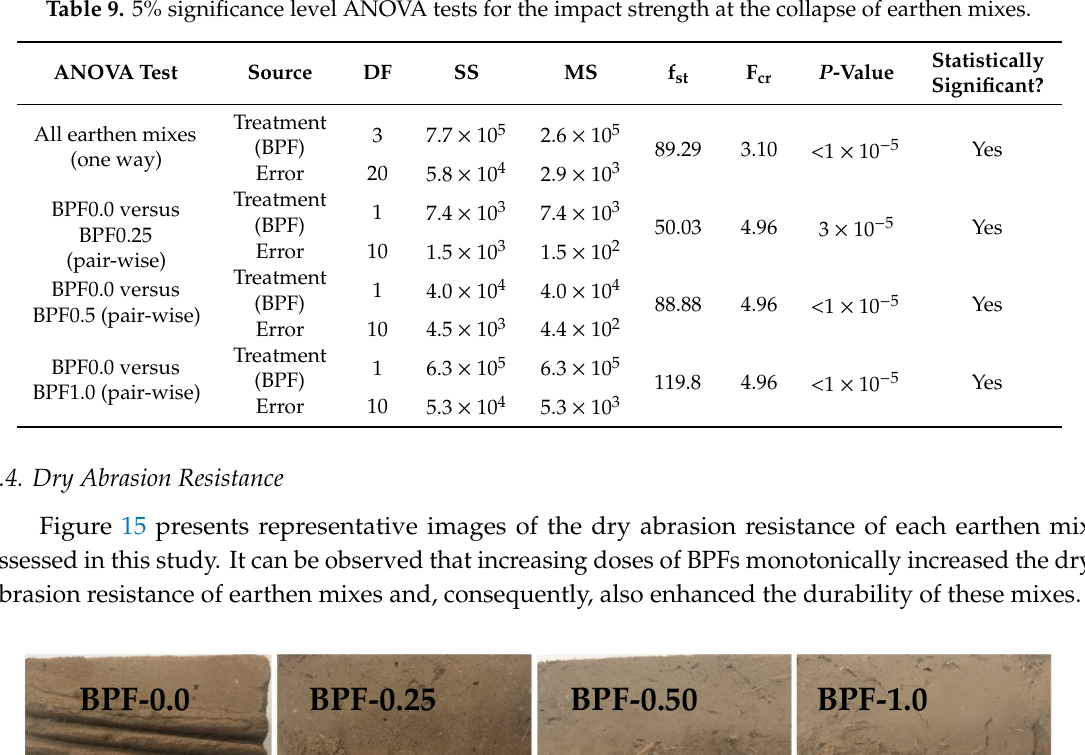
(C a ) ranged from 3.0 cm 2 / g (BPF-0.0) to 6.9 cm 2 / g (BPF-1.0), from 0.64 cm 2 / g (BPF-0.0) to 1.2 cm 2 / g (BPF-1.0), and from 17.5% (BPF-1.0) to 21.4% (BPF-0.0), respectively. As shown by Figure 16, the